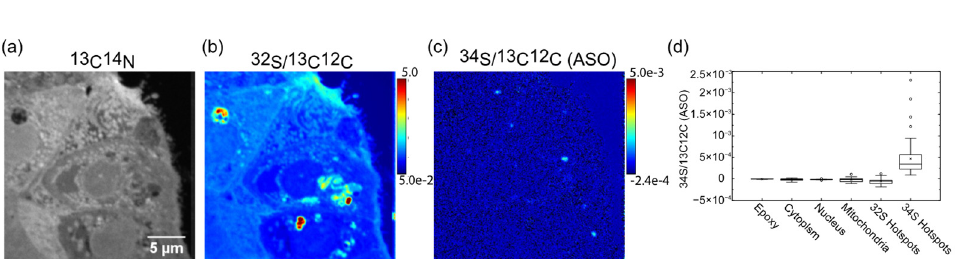
Figure 1. Detection of GalNAc-ASO in human hepatic spheroids; ( a ) 13 C 14 N - image of the perimeter of a hepatic spheroid incubated with GalNAc- 34 S-ASO (711nM) for 24H; ( b ) 32 S - / 13 C 12 C - ratio image of the spheroid; ( c ) 34 S - / 13 C 12 C - ratio image of the spheroid where the 34 S - was calculated as the excess respect to the average 34 S - / 32 S - across the total image and was scaled to the ASO by being divided by the number of 34 S labels per ASO termed 34 S - / 13 C 12 C - (ASO). ( d ) ROI analysis expressed in 34 S - / 13 C 12 C - (ASO) for n = 7 treated hepatocytes analyzed.